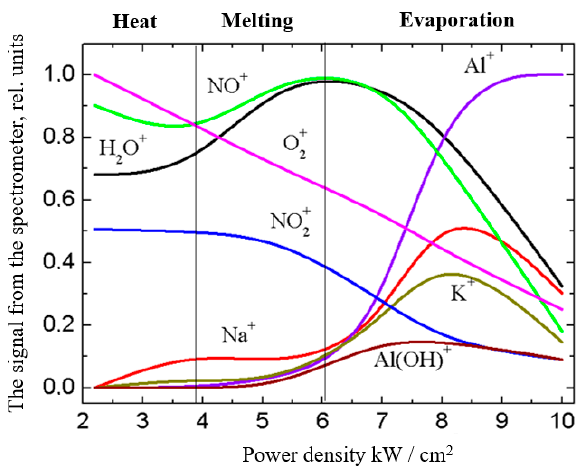
Figure 22. Mass-to-charge composition of the beam-plasma ions in the full cycle of coating deposition. Experimental parameters: I e = 150 mA; U a = 1–15 kV; p = 8 Pa [10].